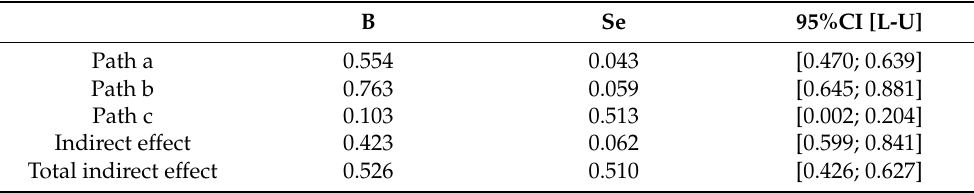
Table 3. Mediation model—direct, indirect, and total